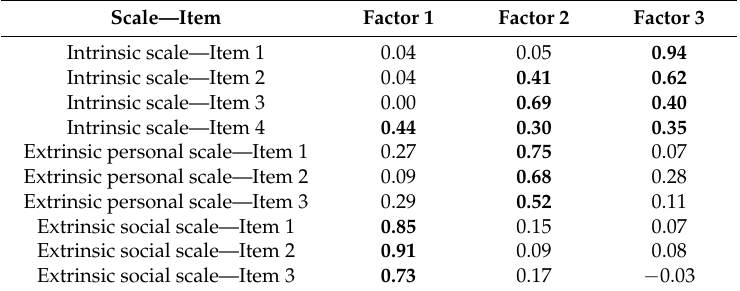
Table 3. Religious orientation: factor loadings 1 of principal axis factoring with Equamax rotation.